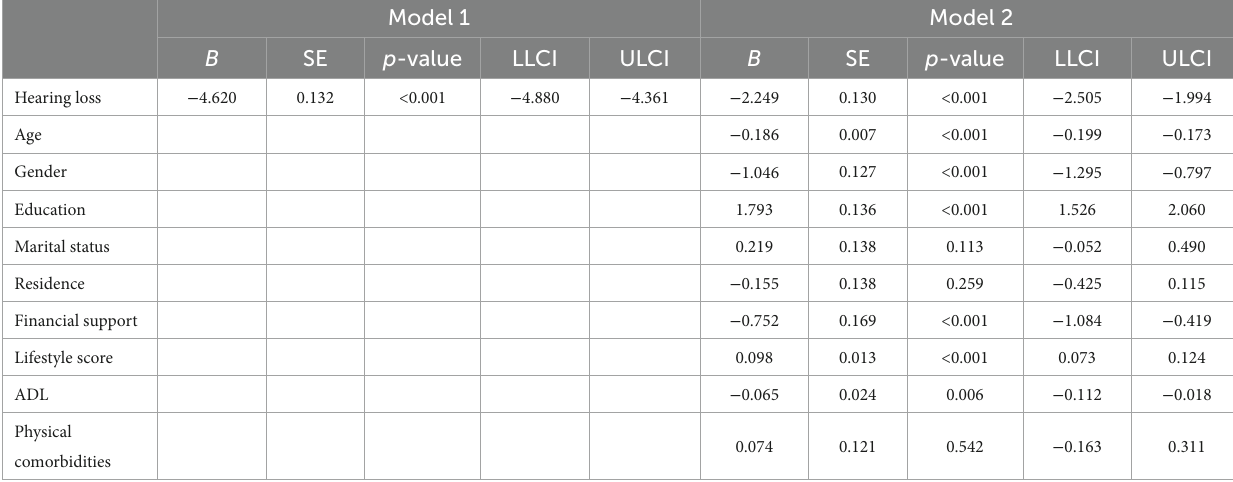
TABLE 3 The association between hearing loss and cognitive function.